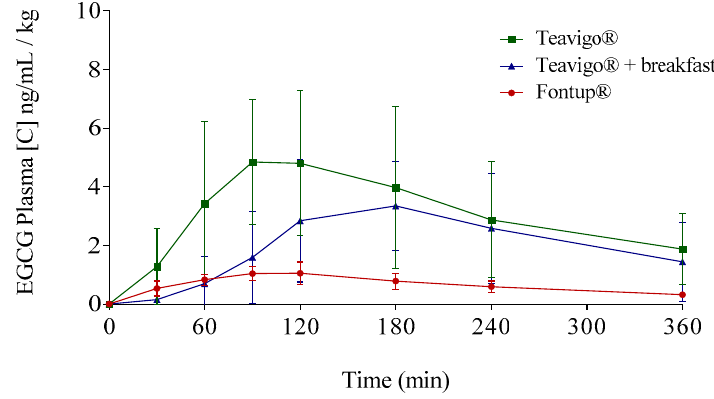
Figure 5. Mean plasma concentration time profiles of EGCG for the three different EGCG interventions by the oral route: Green line represents Teavigo ® , blue line represents Teavigo ® plus breakfast, and red line represents FontUp ® . Each value was obtained by HPLC-MS analysis. Error bars represent the standard deviation.